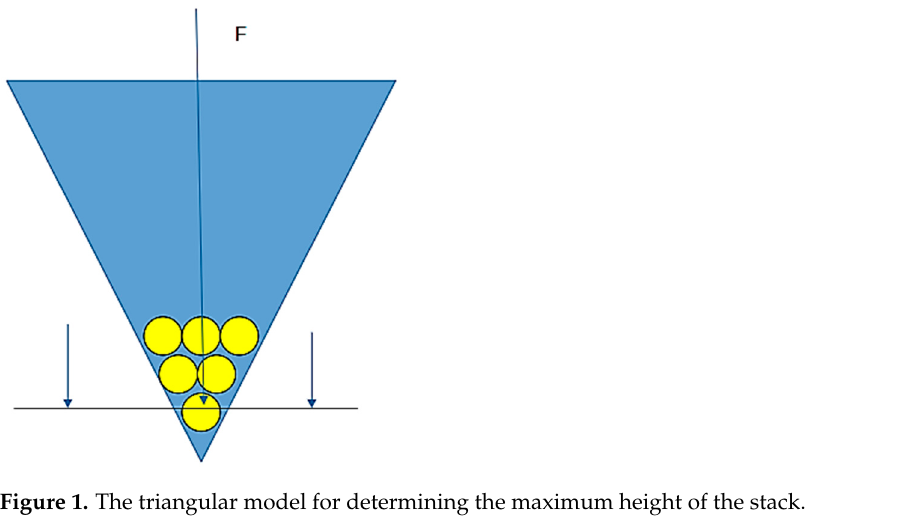
Figure 1. The triangular model for determining the maximum height of the stack.